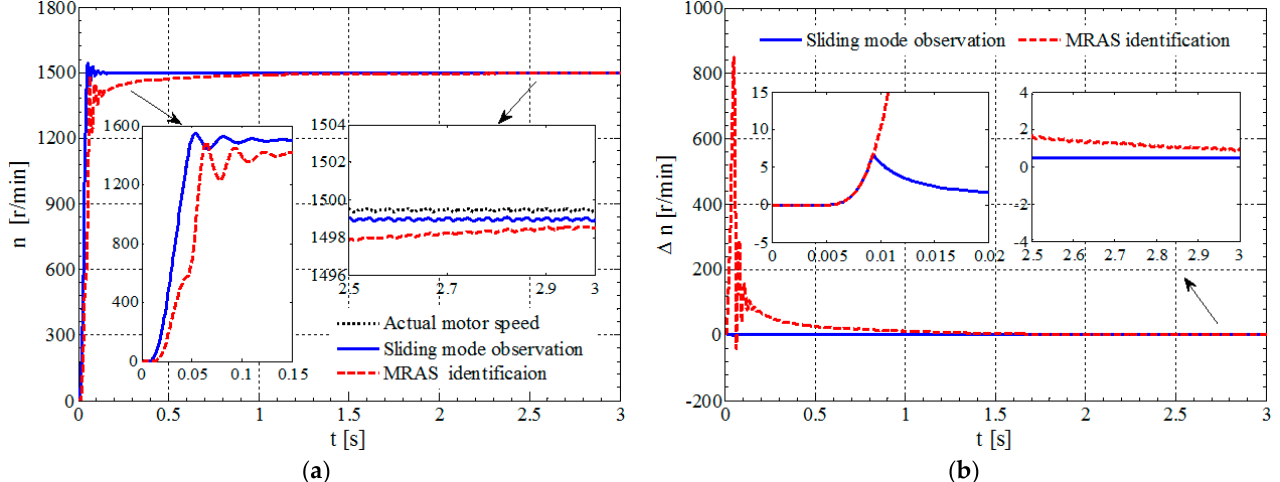
Figure 4. Speed response waveform during no-load start-up: ( a ) Observed motor speed; ( b ) Observation error of motor speed.